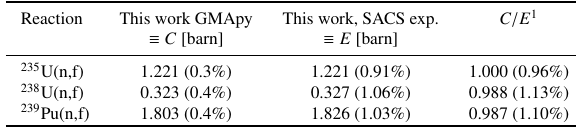
Table 13: Calculated C fission SACS (based on